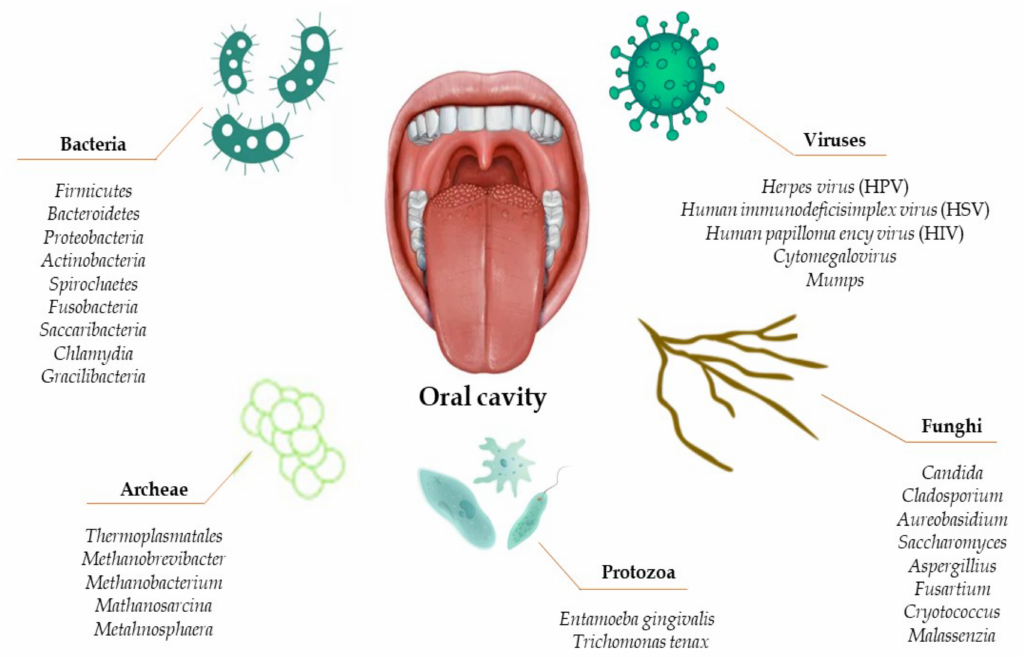
Figure 1. Composition of the human oral